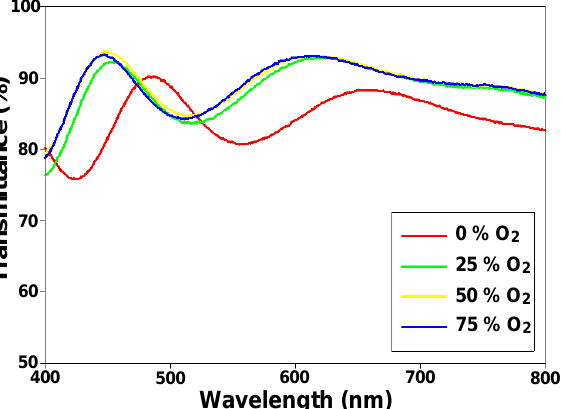
Figure 12. The transmittance of ITO/ITO X /ITO RRAM for the visible wavelength range of 400–800 nm. Top Electrode